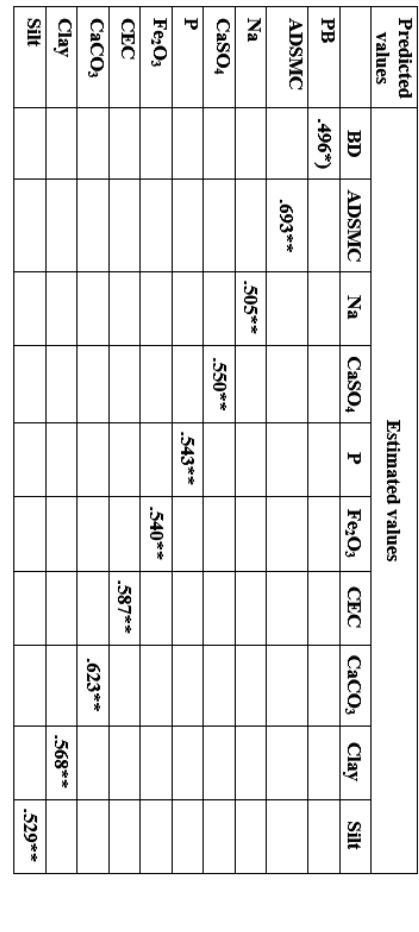
Table 4. The correlation values between the estimated and predicted surface soil properties